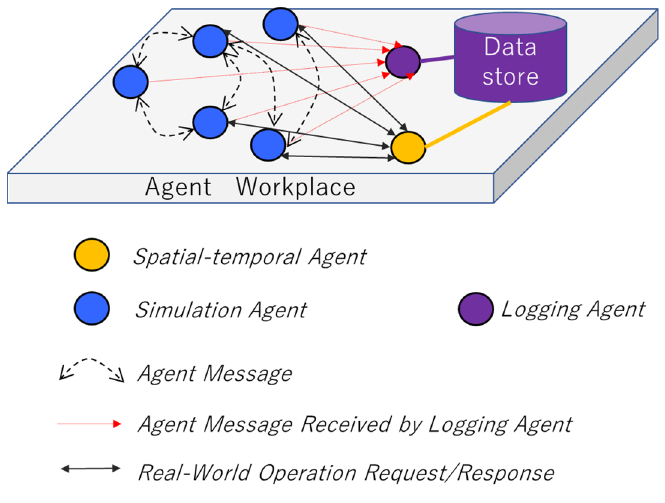
Figure 1. Overview of proposed multi-agent simulation environment.